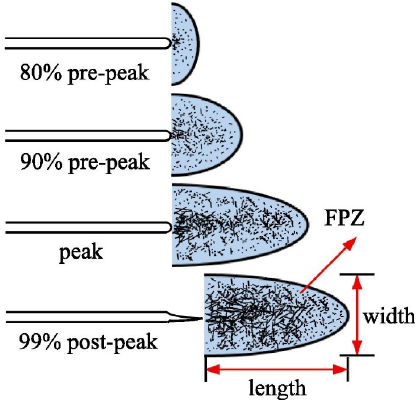
Figure 6. The schematic diagram of the evolution of FPZ with the increasing of load. Reprinted/adapted with permission from Ref. [145]. Copyright 2020, Elsevier.